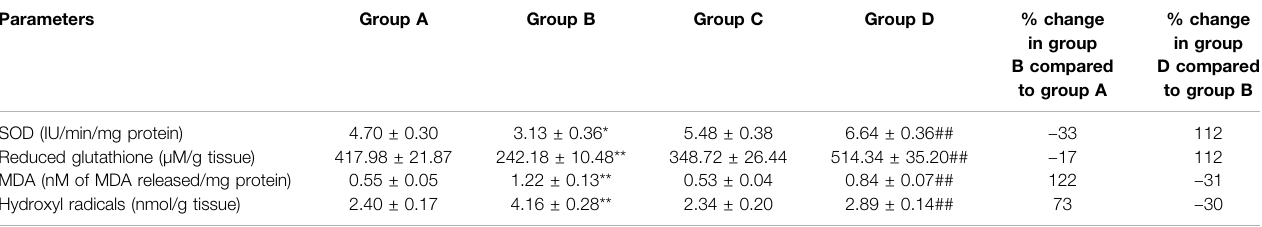
TABLE 2 | Effect of 4-(methylthio)butyl isothiocyanate on enzymatic and non-enzymatic antioxidant levels in control and experimental group of animals. SOD: Superoxide dismutase. All the values are represented as mean ± SEM for sixanimals. Signi fi cant levels are * p < 0.05, ** p < 0.01 when compared with group A and ## p < 0.01 when compared with group